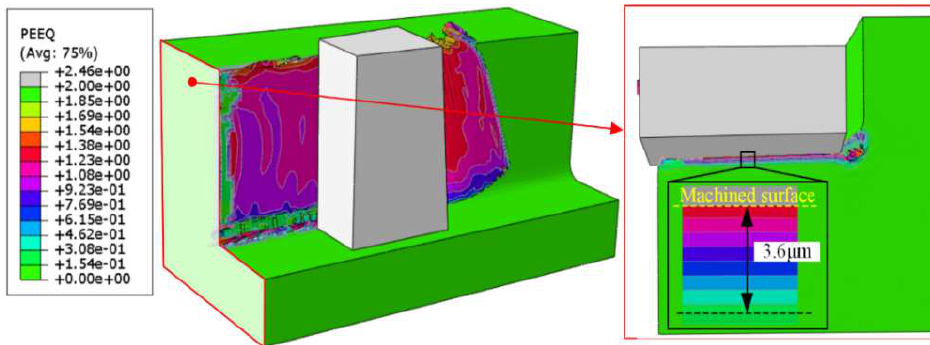
Figure 8. Distributions of strain in the milling of DD407.